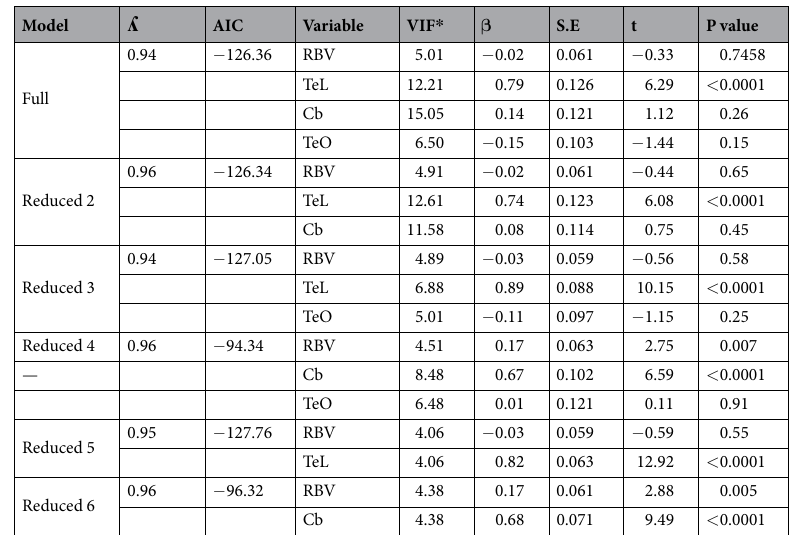
Table 1. Results of PGLS models with SpM as the dependent variable. RBV is the remaining brain volume, brain volume minus telencephalon (Tel.), cerebellum (Cb) and optic tectum (TeO). * Calculated from a non- phylogenetic model, see